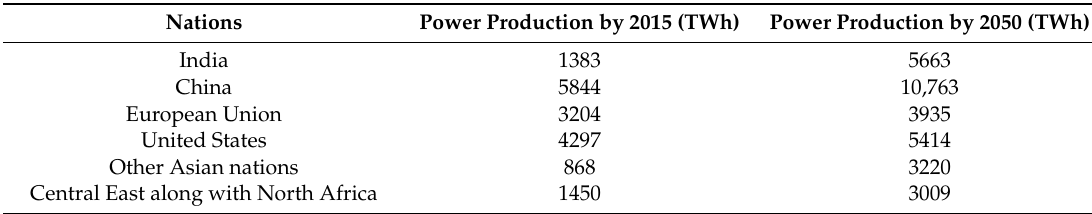
Table 1. World-wide generation of electricity [9]. Nations Power Production by 2015 (TWh) Power Production by 2050 (TWh)